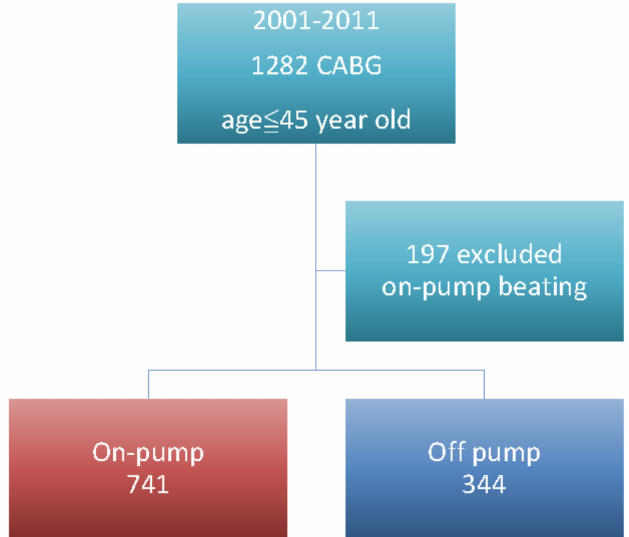
Figure 1. Flowchart of patient enrollment. We included 1282 patients, who were 45 years old or younger, and had isolated on-pump arrest or off-pump coronary artery bypass grafting (CABG). Among them, 197 patients were excluded for the surgeons’ adopted on-pump beating techniques. Mean follow up time was 5.53 years and longest follow up time was 16 years, with 100% complete follow